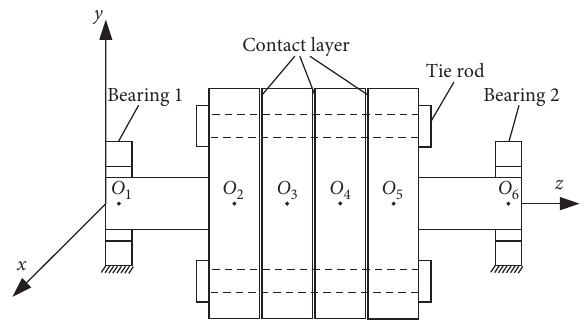
Figure 1: Structural diagram of pull rod